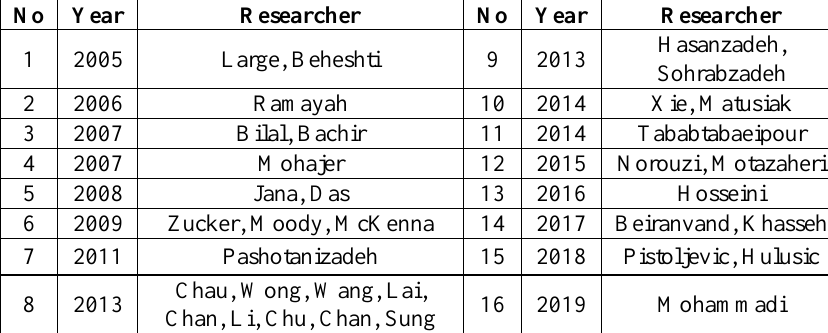
Table 1. Researches related to review of user interface in digital